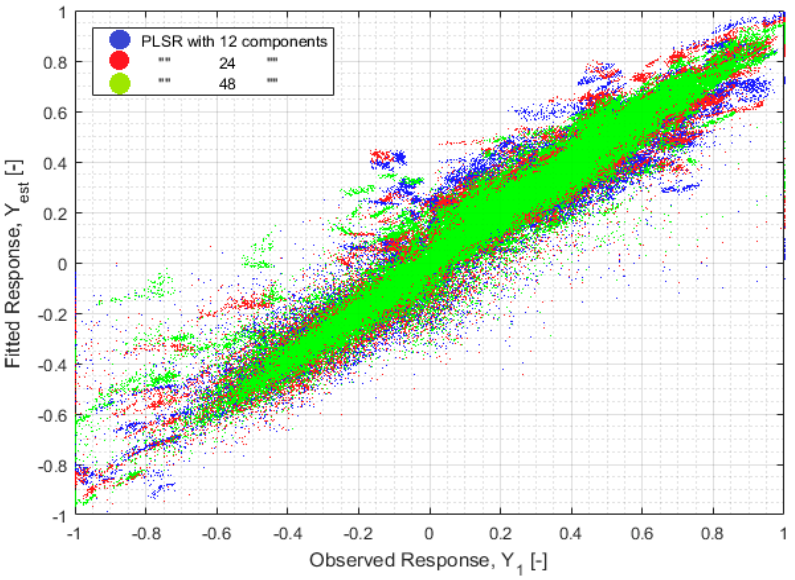
Figure 13. Scatter plot observed- fitted response in function of several number of PLS components used in this work.